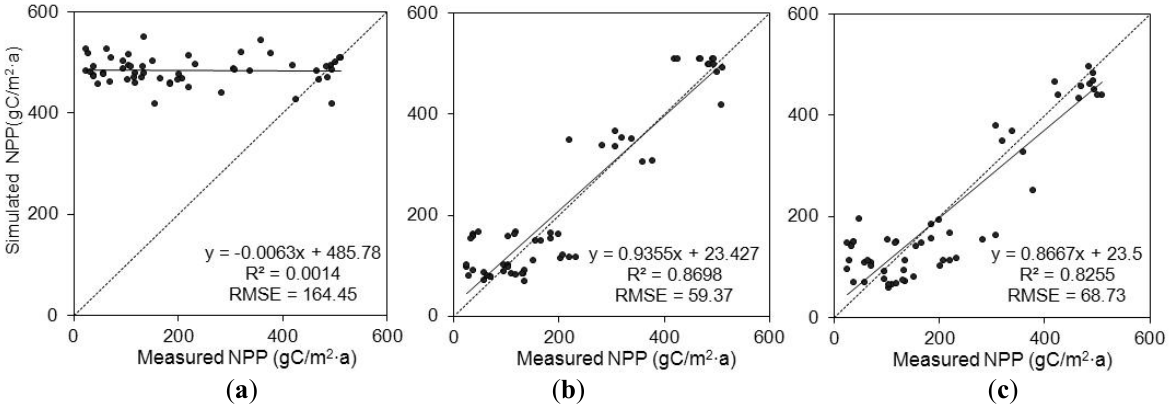
Figure 6. Comparison between the model-simulated NPP and the field-measured NPP ( a ), using the original CASA model directly with no optimization, ( b ) using the derived LUEs of different vegetation covers without time-series NDVI unmixing, and ( c ) using the derived LUEs of different vegetation cover with the time-series NDVI unmixing.